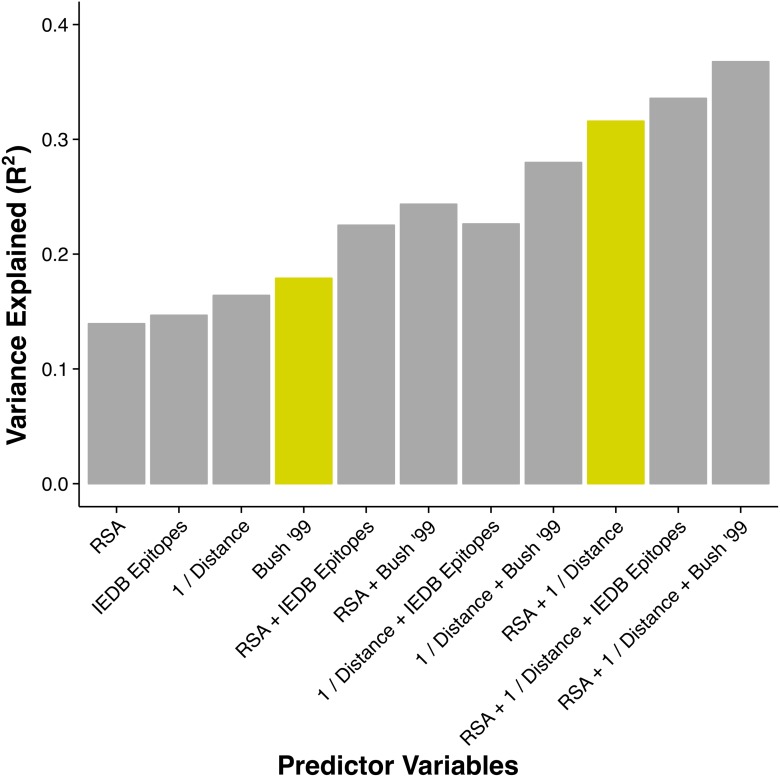
Proportion of variance in dN/dS explained by different linear models.The height of each bar represents the coefficient of determination (R
2) for a linear model consisting of the stated predictor variables. The historical epitope sites from Bush 1999 [4] (yellow bar on the left) are the single best predictor of evolutionary rate variation. However, a model using two predictors that each have a clear biophysical meaning (solvent exposure, proximity to receptor-binding region) explains almost twice the variation in dN/dS (yellow bar on the right).